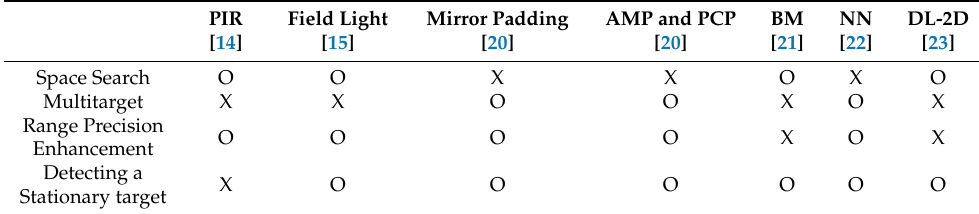
Table 1. Performance of existing